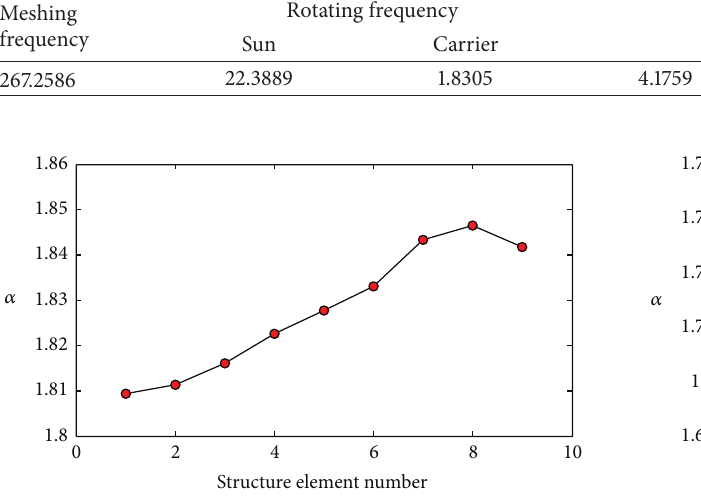
Figure 30: 𝛼 value versus the different SE length.